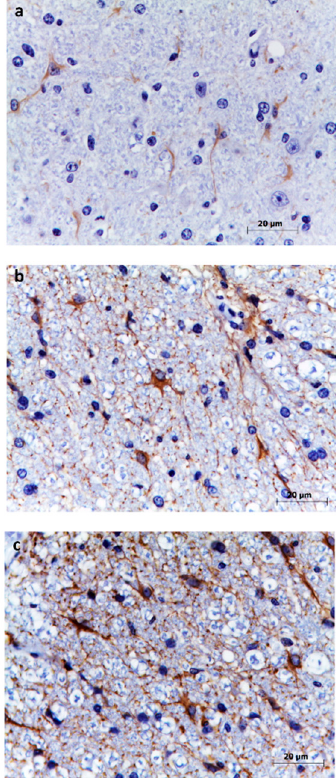
Figure 3. Grading of reactive astrogliosis in cervical spinal cord ( a – c ) using antibodies against GFAP. ( a ) Representative micrograph showing grade 1 (low) reactive astrogliosis. ( b ) Representative micrograph showing grade 2 (mild to moderate) reactive astrogliosis. ( c ) Representative micrograph showing grade 3 (severe) reactive astrogliosis.